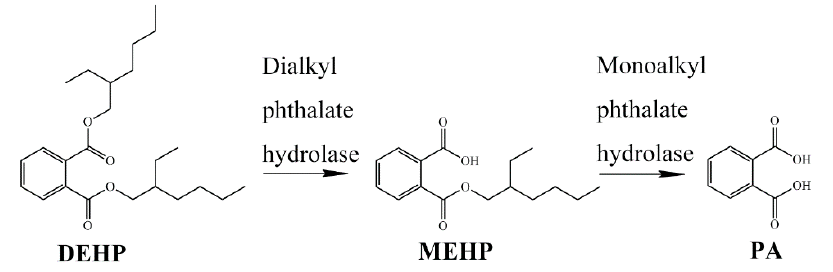
Figure 3. The proposed pathway of DEHP degradation by strain YC-JH1.